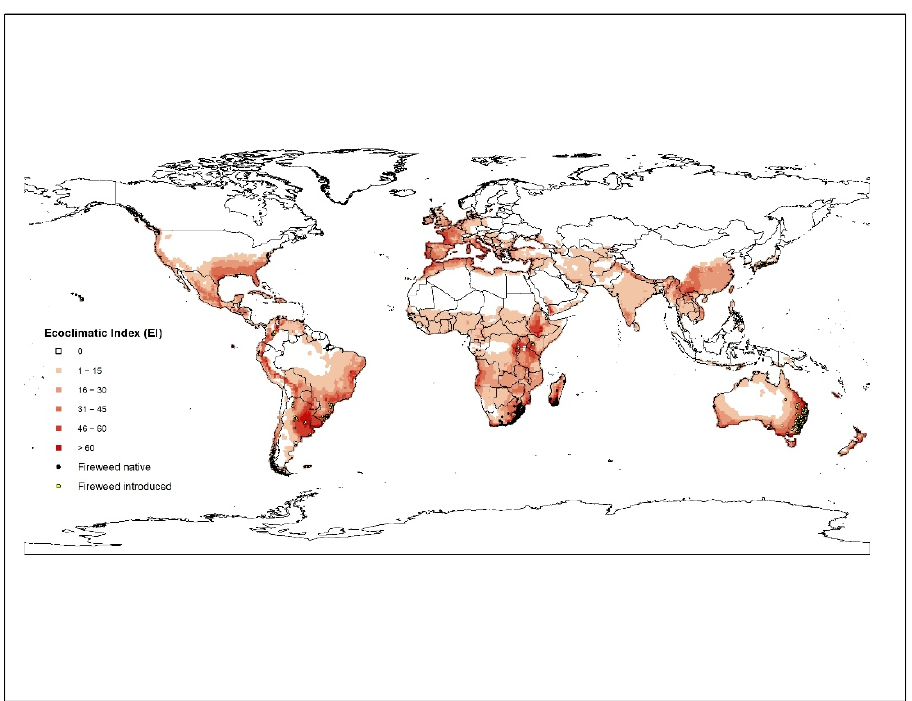
Figure 1. Current distribution (native—green dots; introduced—blue dots) and the climatic suitability for fireweed under the current climate modelled using CLIMEX.